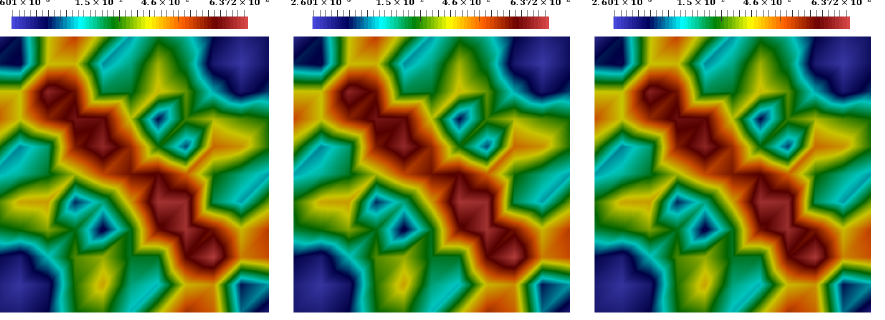
Figure 11. Distributions of the strain at the final time. The coupled explicit–implicit solution, the split explicit–implicit solution, and the proposed approach’s solution(from left to right